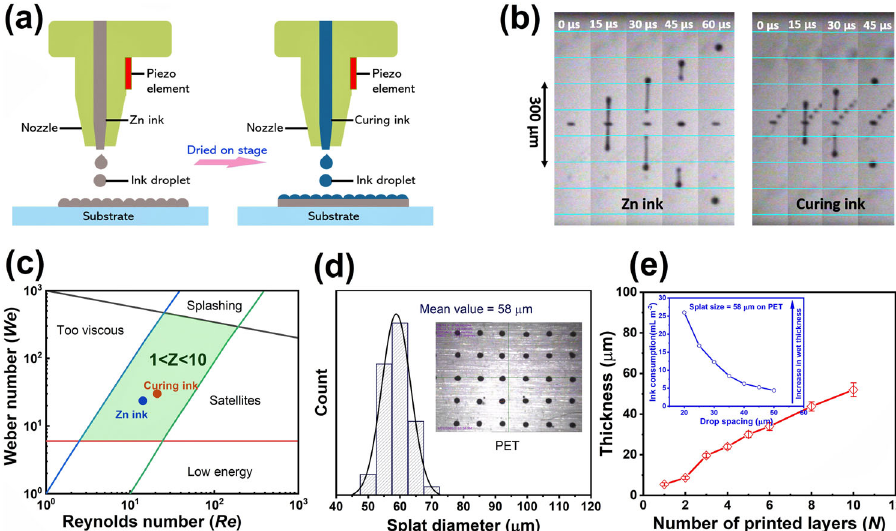
Fig. 1 Formulation and printing of Zn NP ink and curing ink. a Inkjet printing of Zn ink followed by curing ink on PET substrates. b Drop formations of the Zn ink and the curing ink from the nozzles, respectively. c The dimensionless Z values of Zn and curing inks in the Weber number vs Reynolds number plot. d Splat diameter histogram for Zn ink and the droplets on PET substrate (inset). e Variation of the Zn layer dry thickness with a number of printing layers (Inset: ink consumption vs drop-spacing estimation). Standard deviations for the thickness measurements are shown as error bars. Lines are guides for the